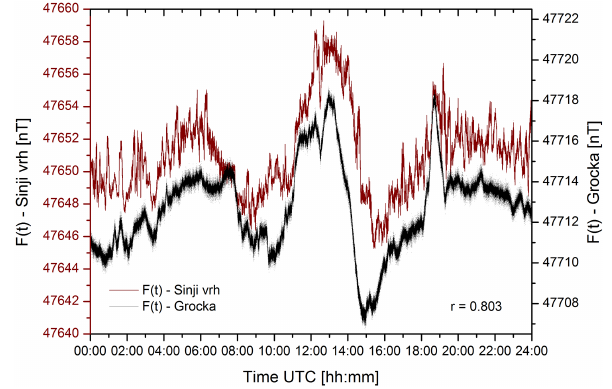
Figure 6. Change in the absolute value of the geomagnetic field vector F (t) recorded at the Observatory and the GCK Geomagnetic Observatory during the 15 January 2013 snowstorm.